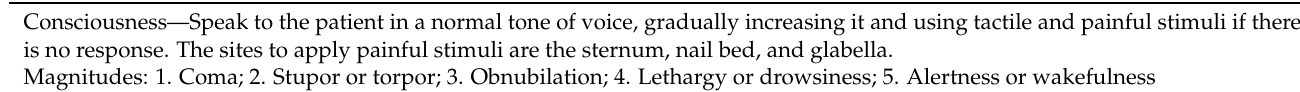
Table A1. Operational definitions of the indicators of the nursing outcome “Neurological